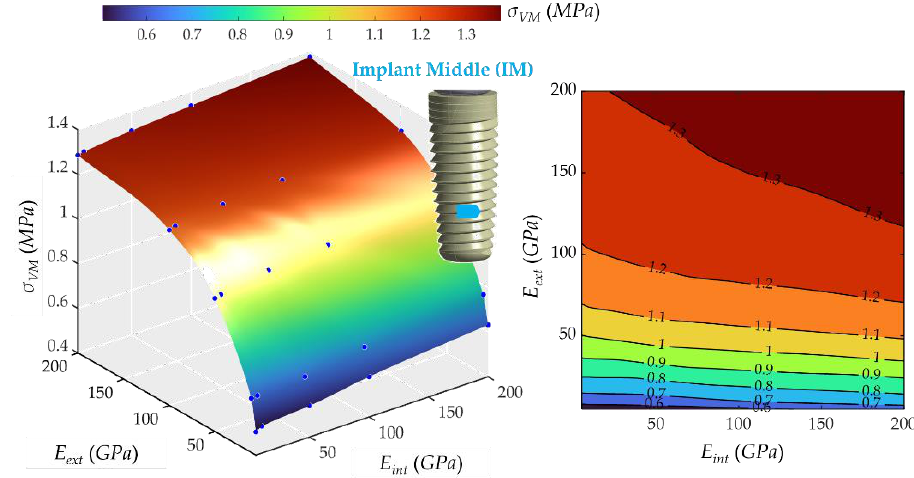
Figure 11. Von Mises maximum stress at the middle part of the implant. ( Left ): 3D representation. (Right ): vertical projection.